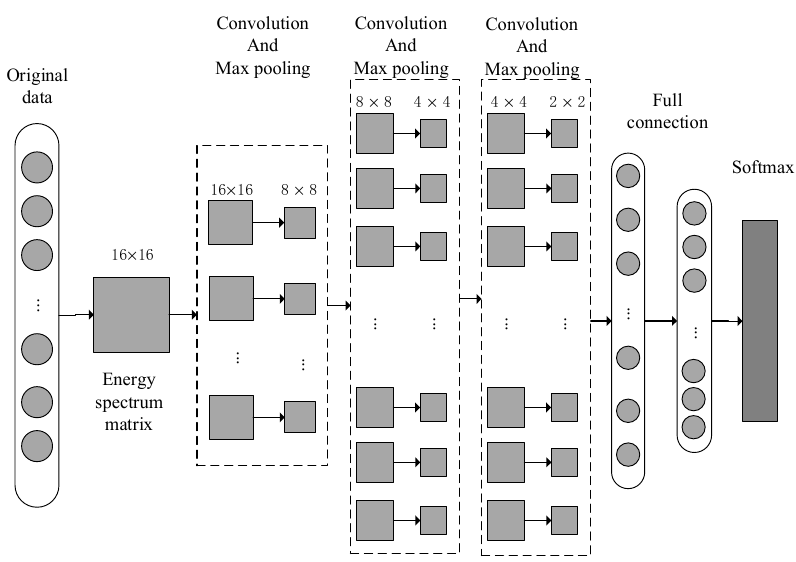
Figure 3. Sub-model structure corresponding A-HDCNN.